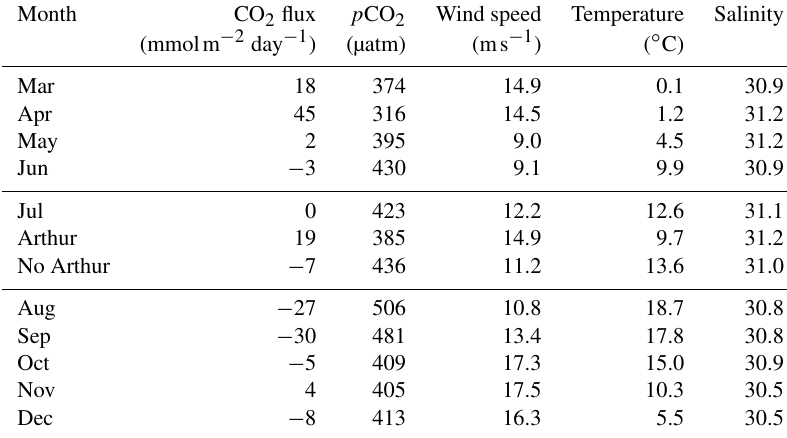
Table 1. Average daily sea–air fluxes (mmolm − 2 day − 1 ) for each month available for 2014 using the Wanninkhof (2014) method. July is broken into three components: the month as a whole, the 8 days Hurricane Arthur impacted p CO 2 , and the remaining 22 days averaged without Hurricane Arthur. p CO 2 (µatm), wind speed (ms − 1 ), temperature ( ◦ C), and salinity are averaged for each month (or segment in the case of Arthur and no